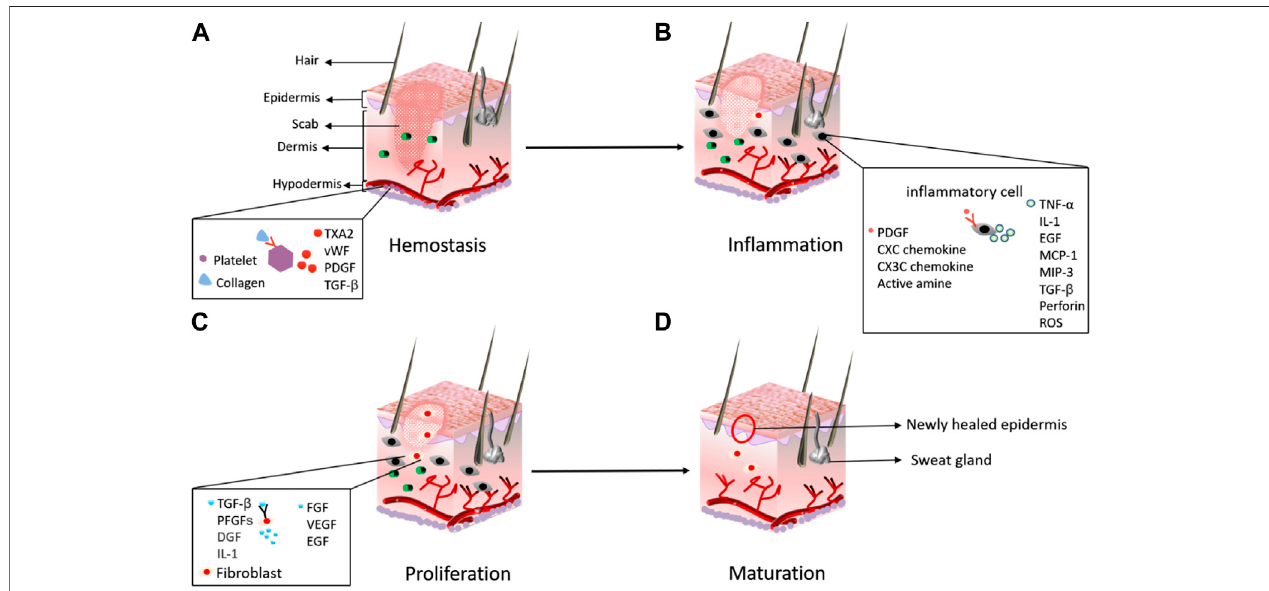
FIGURE 2 | Major stages in the process of wound healing: (A) hemostasis; (B) in fl ammation; (C) proliferation; and (D) maturation (Su et al., 2021).